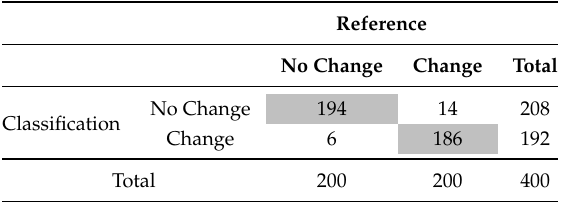
Table 4. Change detection validation for Prague (OA = 95%; K = 0.90).